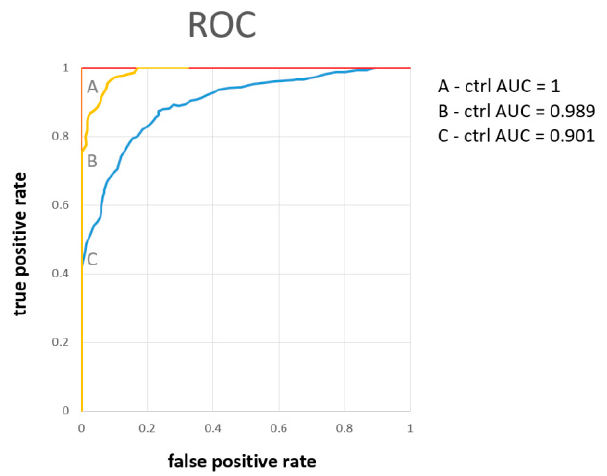
Figure 4. The ROC curve derived from the random forest discriminatory algorithm for binary systems patients on the first day of hospitalization ( A ), one week ( B ), and one month later ( C ), as input variables were used concentrations of urine metabolites related to the level of creatinine.